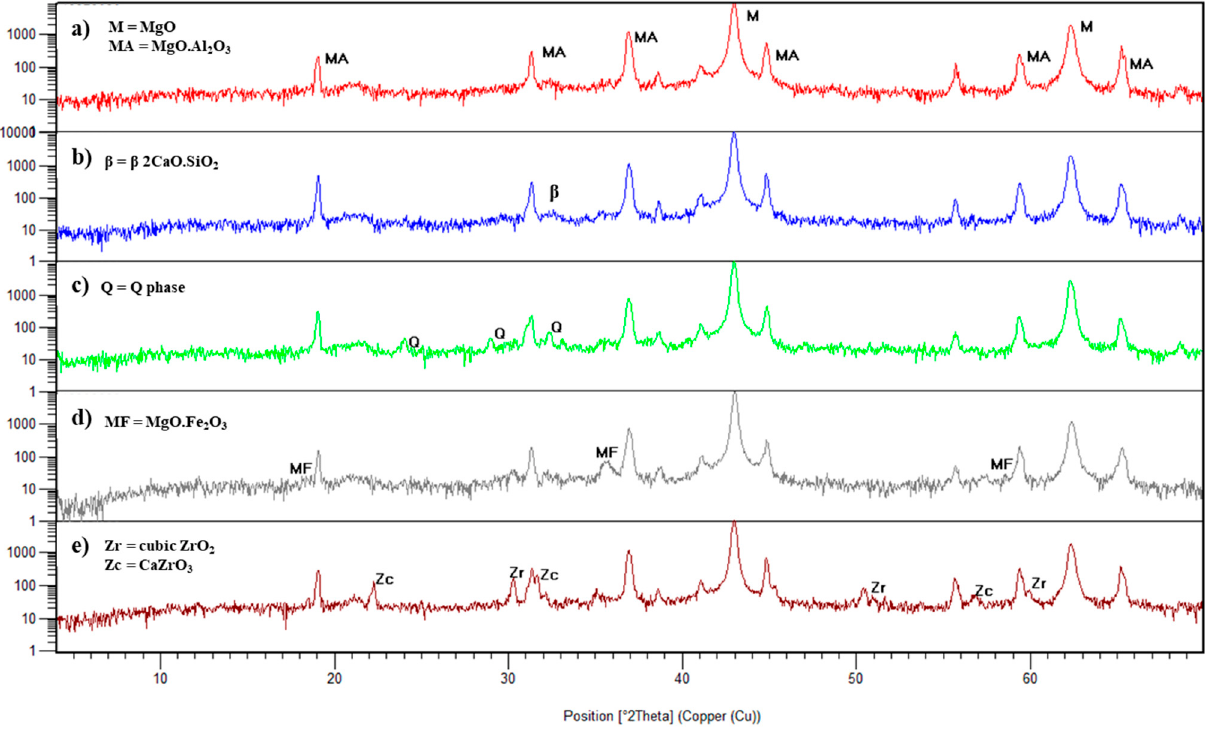
Figure 2. X-ray diffraction patterns of compositions ( a ) A-6, ( b ) A-7, ( c ) A-8, ( d ) A-9 and ( e ) A-10. Figures 3 and 4 illustrate the microstructure of A-1 to A-10. All compositions pre- sented homogeneous distribution of magnesia and fused spinel raw materials. Good sin- tering degree was obtained by A-4, A-6, A-7, A-9 and A-10 compositions. A refractory structure with a suitable sintering degree presents larger bonds among the particles,